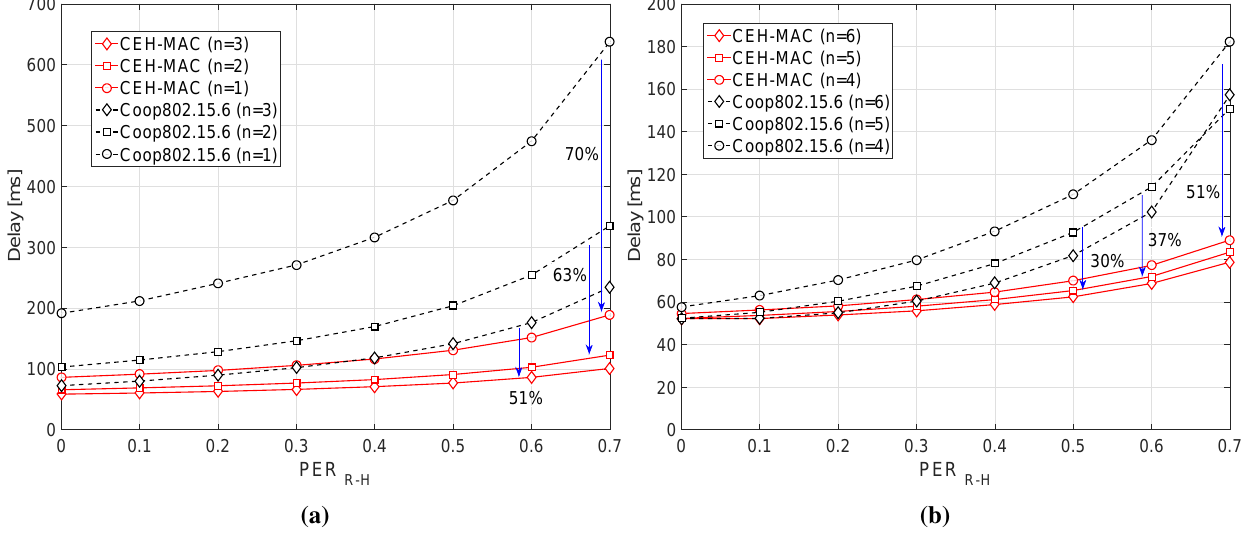
Figure 7. Delay performance. ( a ) n = 1 , 2 , 3 relays; ( b ) n = 4 , 5 , 6